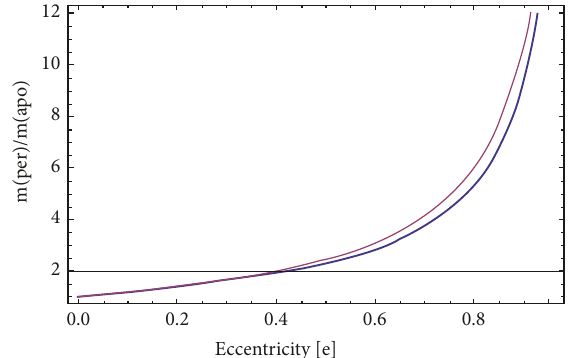
Figure 3: Mass ratio of the mediating the Yukawa interaction particle as it is felt by Mercury at perihelion and aphelion is plotted as a function of eccentric anomaly for 𝜆 = 5.79 × 10 15 m and 𝛼 = 3.04 × 10 −8 , 3.57 × 10 −11 . 0.205, olive green e = 0.6, and green e = 0.9, and for eccentric anomaly values during one full revolution. Similarly, in Figure 2 we plot the Yukawa function for planet Mercury as a function of eccentric anomaly and during one full